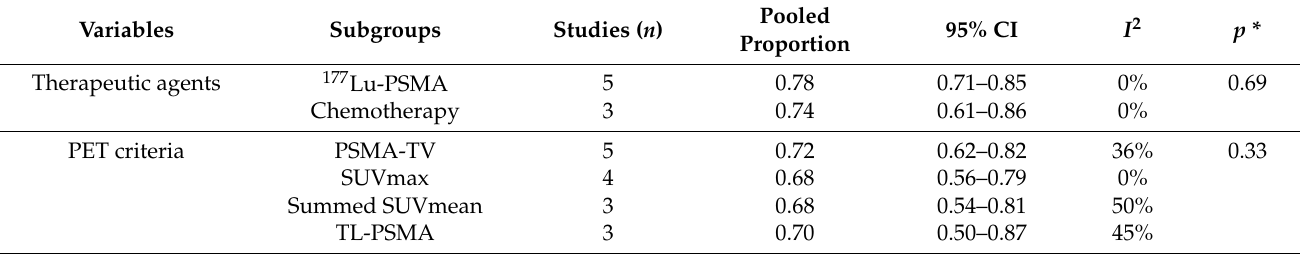
Table 3. Subgroup analysis of concordant proportion between PSA and PSMA PET response as- sessments stratified to therapeutic agent and PSMA PET criteria.